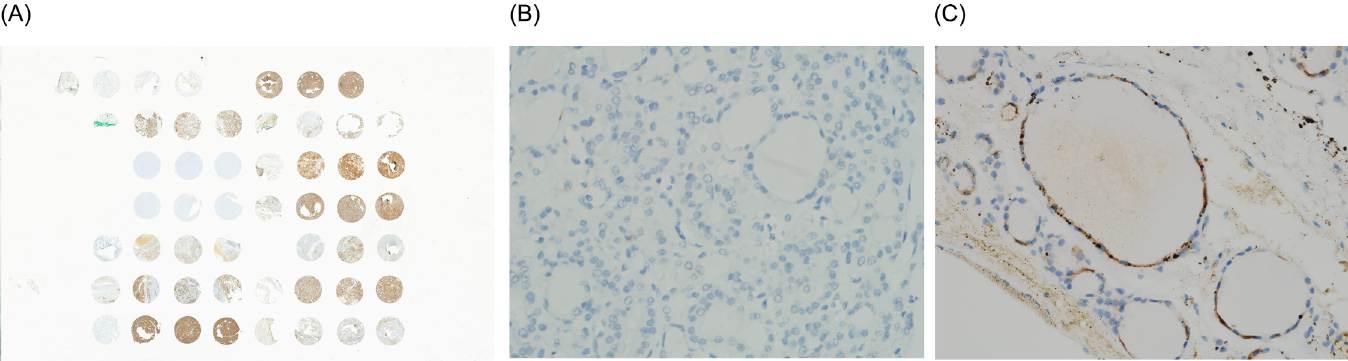
Fig 2. CK expression in minimally invasive follicular thyroid carcinoma. (A) Overview image of TMA slide stained by CK19, (B) negative staining and (C) positive staining for CK19 (immunohistochemistry, original magnification